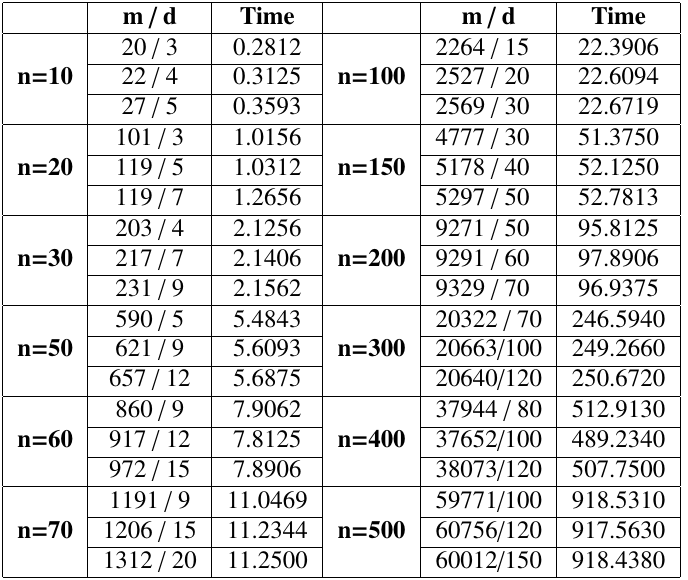
Table 2. The change to the runtime of AG (seconds) m /